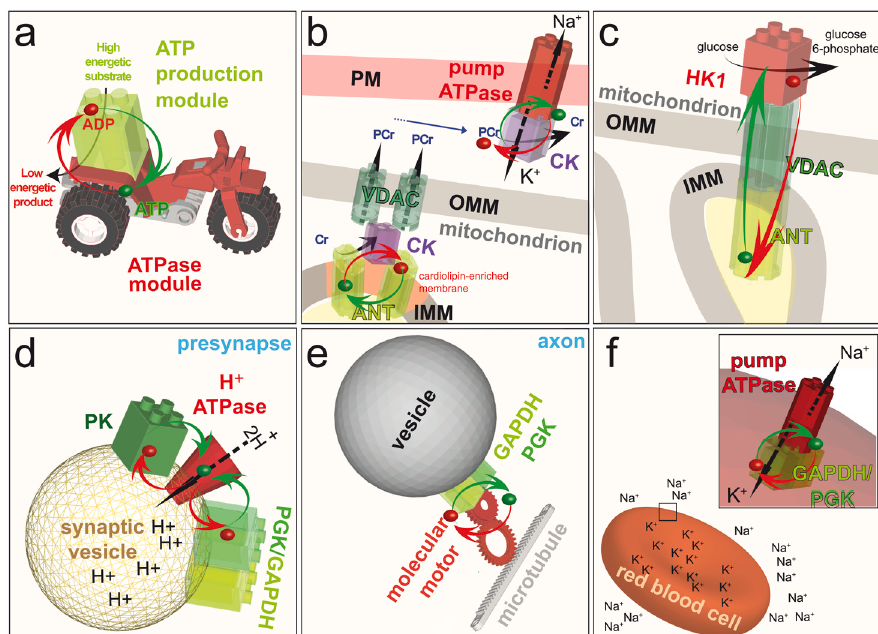
Figure 5. Examples of ATP channeling. a : Model of the energetic channeling between an ATP production module (green) in close proximity to an ATPase module (red). ADP and a high energy substrate is converted by the ATP production module to a low energy product and ATP. The ATP (green dot) and ADP (red dot) channel between the two modules (red and green arrows) to fuel a cellular function. Note that in the following panels, ATP, ADP and most of the substrates and products are removed to highlight the energetic channeling. b : In the mitochondrion, CK (purple) is bound to the IMM through its interaction with the anionic phospholipid cardiolipin, where it comes into close proximity with the ANT. CK uses the ATP exported by ANT to generate PCr, which is exported from the mitochondrion by the VDAC. In the cytosol, CK uses PCr to channel ATP directly to the Na + /K + -ATPase in the PM. Thus, CK functions as an ATP production module in the PM and as an ATPase module in the mitochondrion. c: Coupling of the ATP-exporting VDAC and ANT in mitochondria to the ATP-consuming enzyme HK1 in the cytosol fuels the first step of the preparatory phase of glycolysis: conversion of glucose to glucose 6-phosphate. d: Coupling of the cytosolic ATP- producing module GAPDH–PGK, or the ATP-producing enzyme PK, to the H + -ATPase in the membrane of synaptic vesicles at the presynapse fuels the transport of protons into the vesicles. e: On-board coupling of the ATP-producing module GAPDH–PGK to a molecular motor enables fast axonal transport along microtubules. f: Coupling of the ATP-producing module GAPDH–PGK to the Na + /K + -ATPase pump in the plasma membrane of red blood cells fuels ion transport to maintain cell shape. ADP, adenosine diphosphate; ATP, adenosine 5’-triphosphate; PM, plasma membrane; IMM, inner mitochondrial membrane; OMM, outer mitochondrial membrane; CK, creatine kinase; ANT, adenine